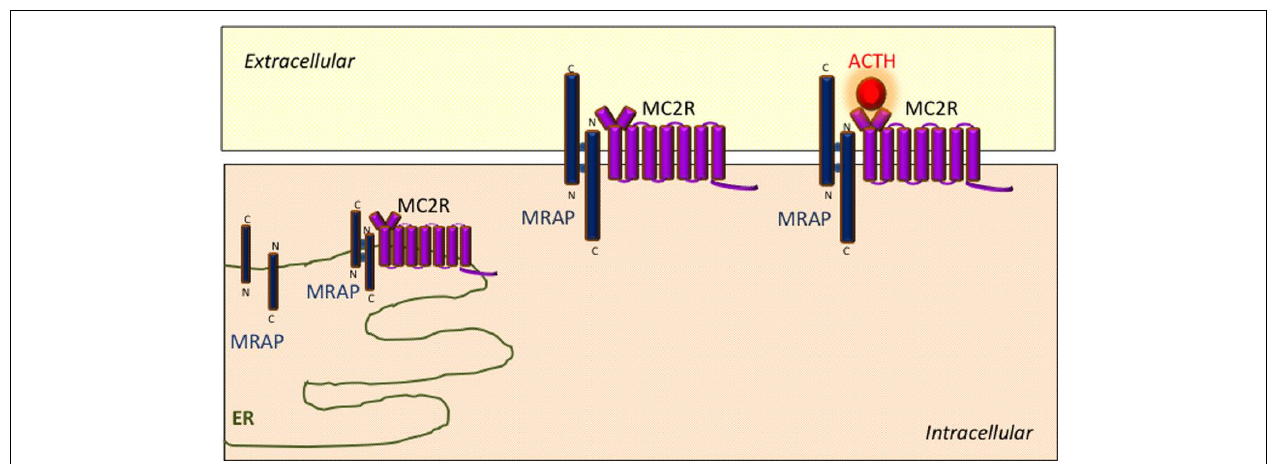
FIGURE 2 | Schematic representation of the role of MRAP in MC2R signaling. MRAP monomers form unique anti-parallel homodimeric complexes in the endoplasmic reticulum which interact with MC2R and assist its trafficking to the cell surface.The MRAP/MC2R structure is capable of binding ACTH at the cell surface and initiating intracellular signaling.